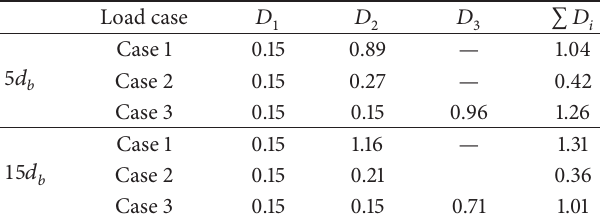
Table 5: Linear cumulative damage of the specimens under an amplitude loading